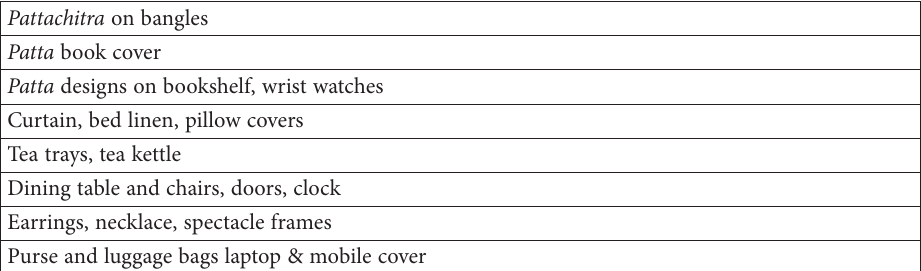
Table 4. Ideas of artisans: Probable innovative products (source: created by authors) Pattachitra on bangles